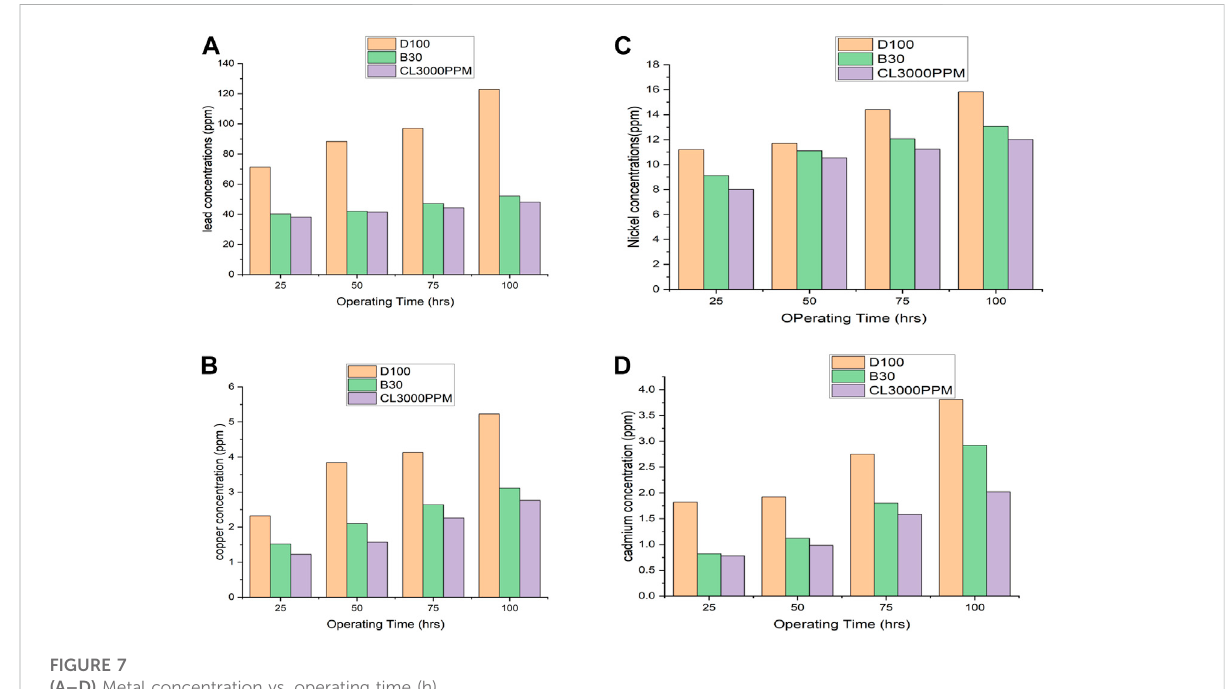
FIGURE 7 (A – D) Metal concentration vs. operating time (h).